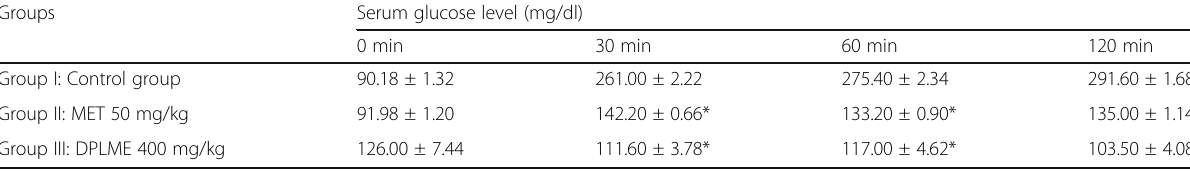
Table 1 Effect of methanolic leaf extract of D. pentandra on fasting Rats after oral glucose intake Groups